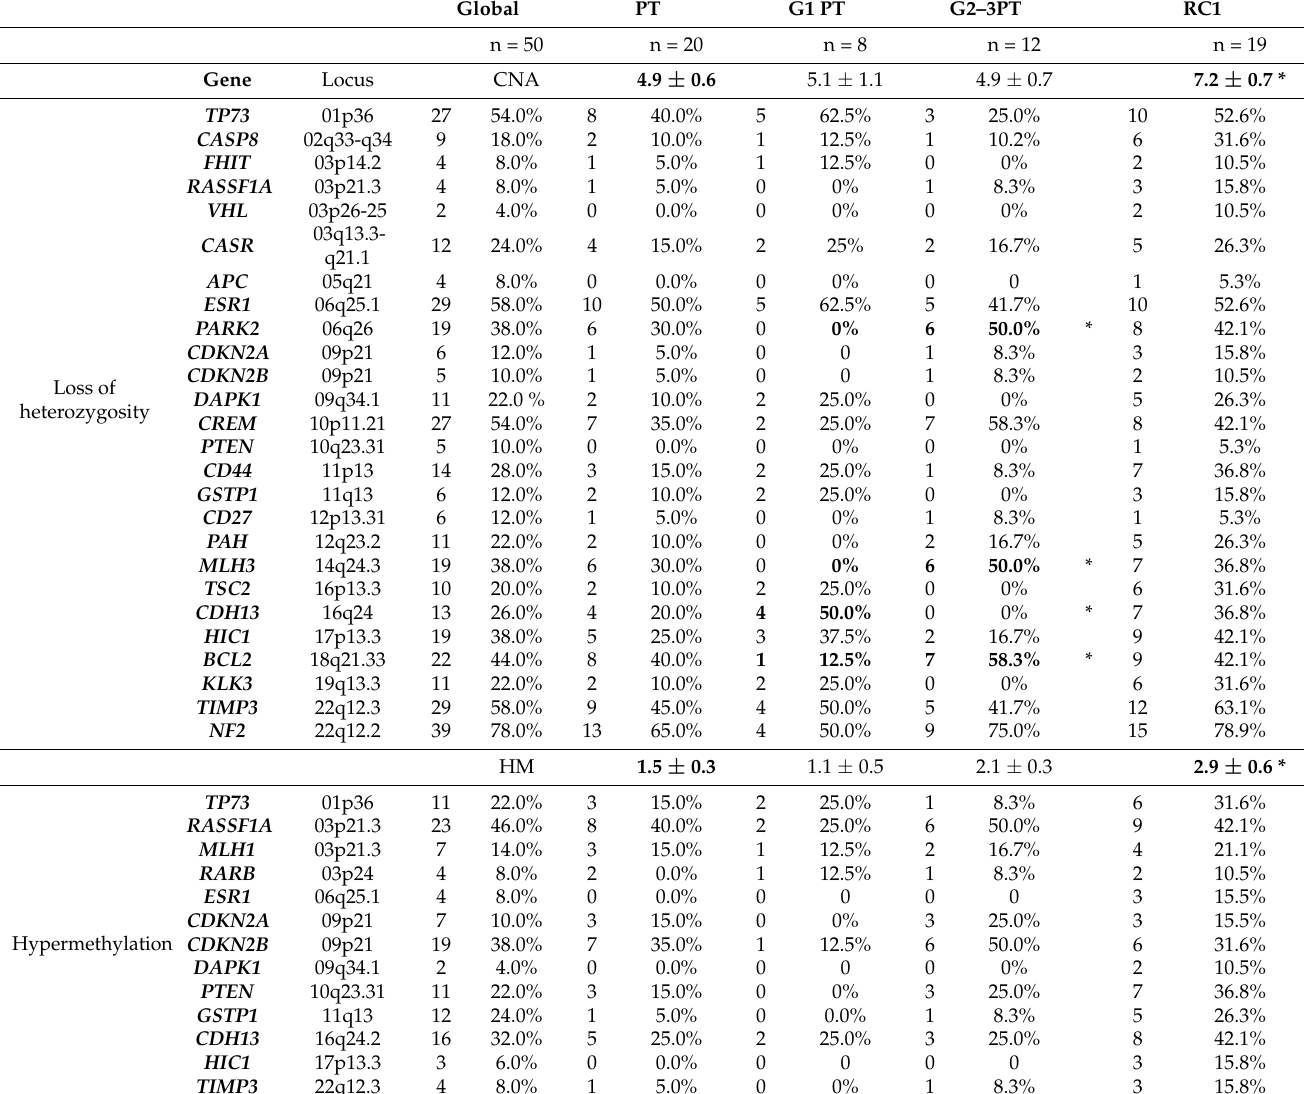
Table 2. Distribution of genetic and epigenetic alterations.